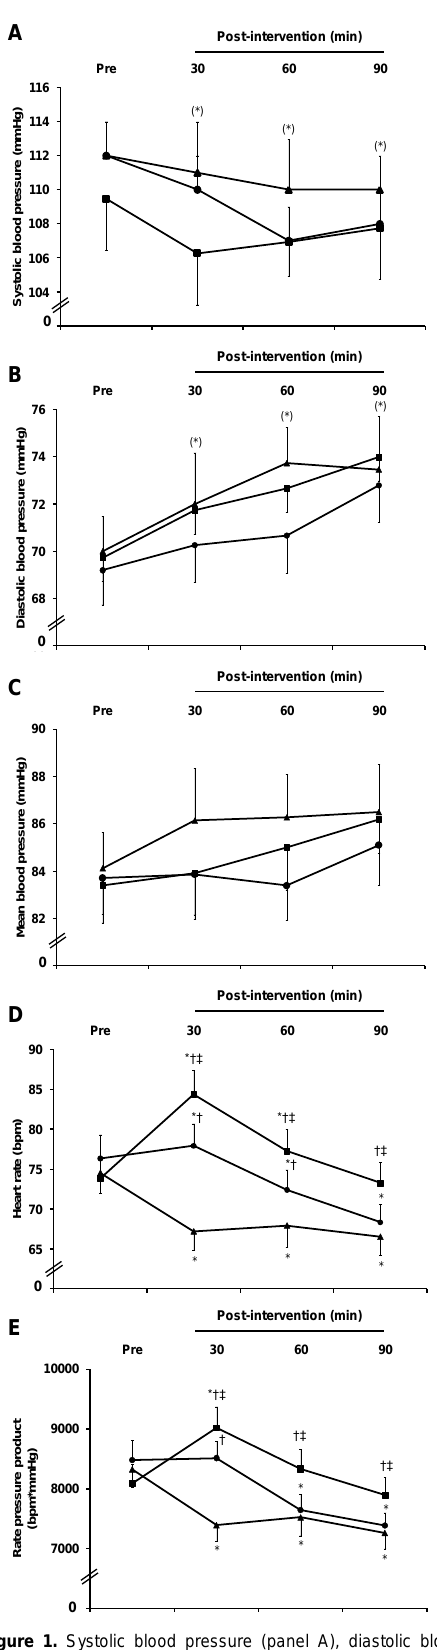
Figure 1. Systolic blood pressure (panel A), diastolic blood pressure (panel B), mean blood pressure (panel C), heart rate (panel D), rate pressure product (panel E) responses observed before (Pre) and after the interventions in the control (triangles), resistance exercise performed at 50% of 1 RM (circles), and resistance exercise performed at 70% of 1 RM (squares). * Significantly different from pre exercise (p< .05). † Significantly different from control. ‡ Significantly different from exercise at 50% of 1 RM. ( ) Main stage effect